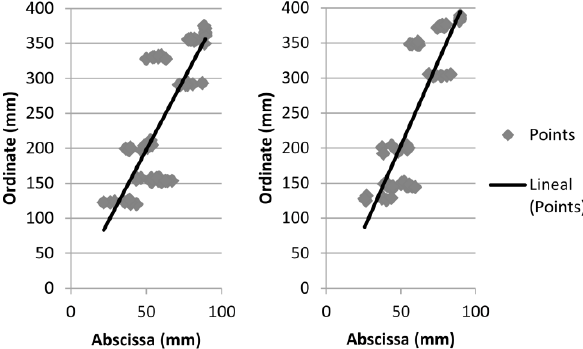
Figure 12. Least squares calculation: the Cathedral of Seville (left) and the Church of Santiago